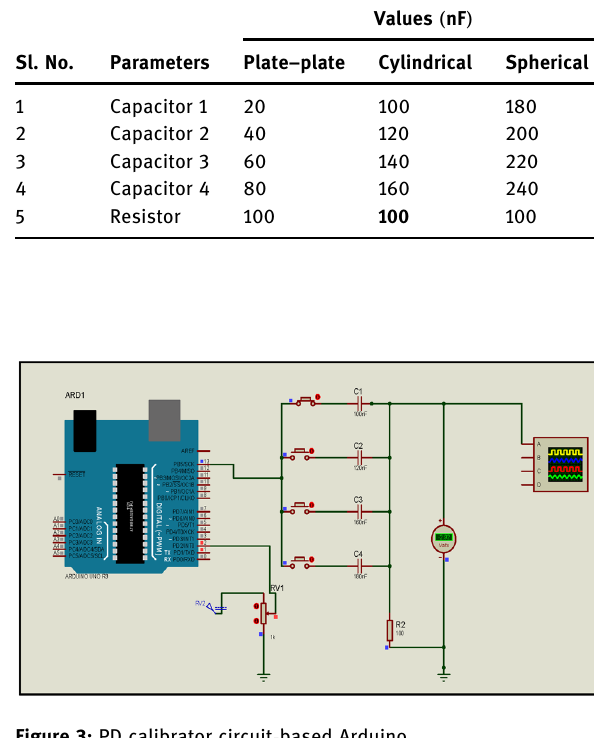
Figure 3: PD calibrator circuit - based Arduino.